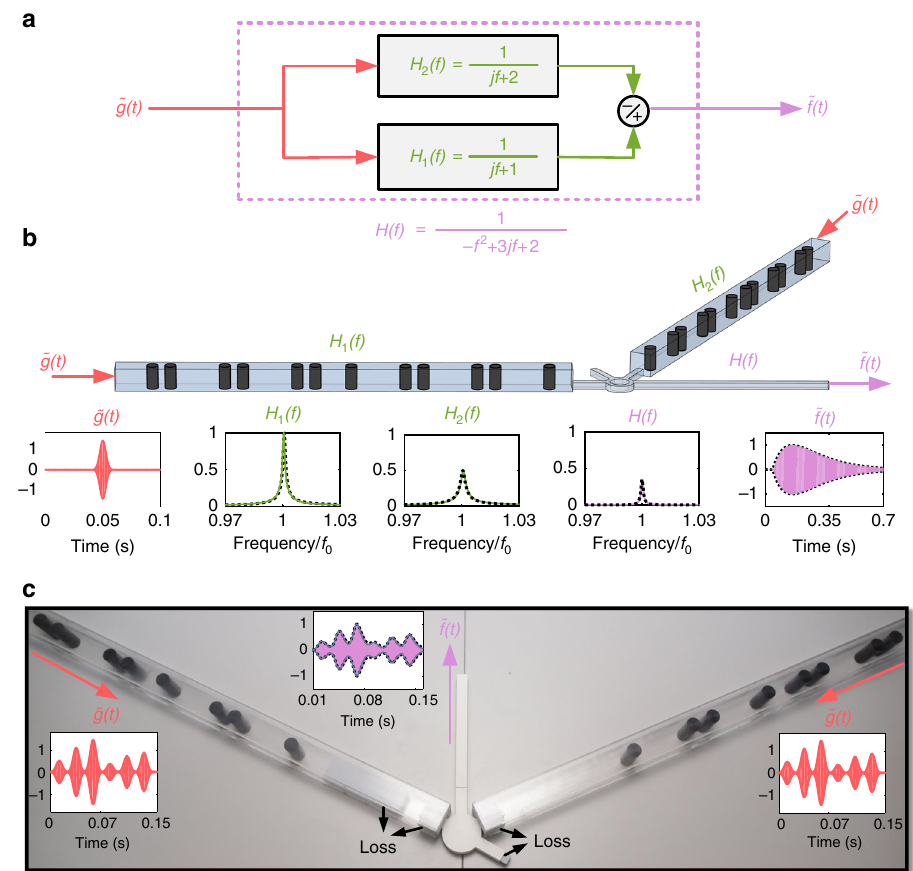
Fig. 5 Robust resolution of a second-order differential equation. a The second-order transfer function associated with the resolution of the equation f ″ ( t ) + 6 π f ' ( t ) + 8 π 2 f ( t ) = 4 π 2 g ( t ) can be achieved by proper subtraction of two fi rst-order transfer functions. b Implementation of the scheme in panel ( a ) with two topological fi rst-order differentiators. The signal subtraction is realized with a rat-race coupler (circular component connecting the two systems). The bottom panels represent full-wave numerical simulations of the complete 3D structure in the case of a Gaussian pulse input, demonstrating that the targeted signal processing task is indeed performed by the system. c Experimental realization of the second-order differential equation solver. The measured output signal envelope ( f ( t ), purple lines) is found to be in perfect agreement with both the numerical simulation (gray) and with the exact solution of the corresponding second-order differential equation (dashed